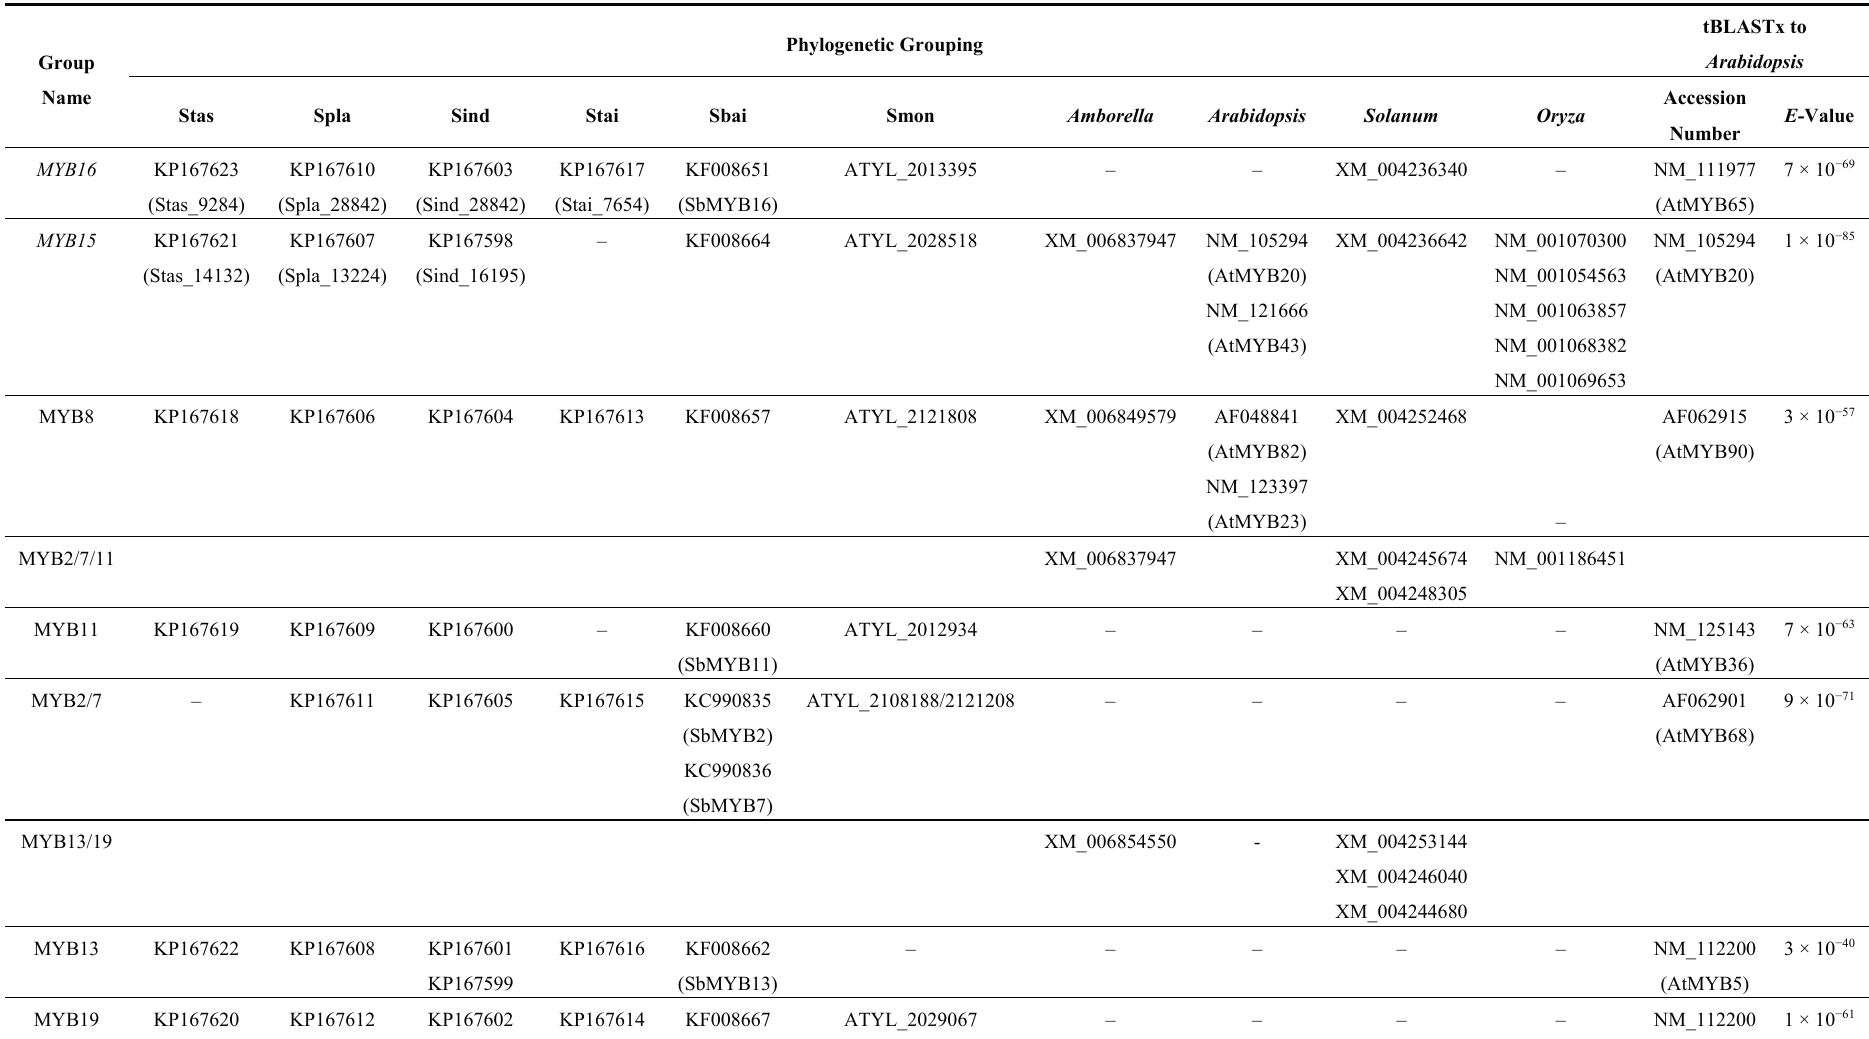
Table 3. Grouping of R2R3-MYBs by phylogenetic analysis and tBLASTx result by searching to Arabidopsis thaliana . The grouping name was based on the R2R3-MYBs of Scutellaria baicalensis